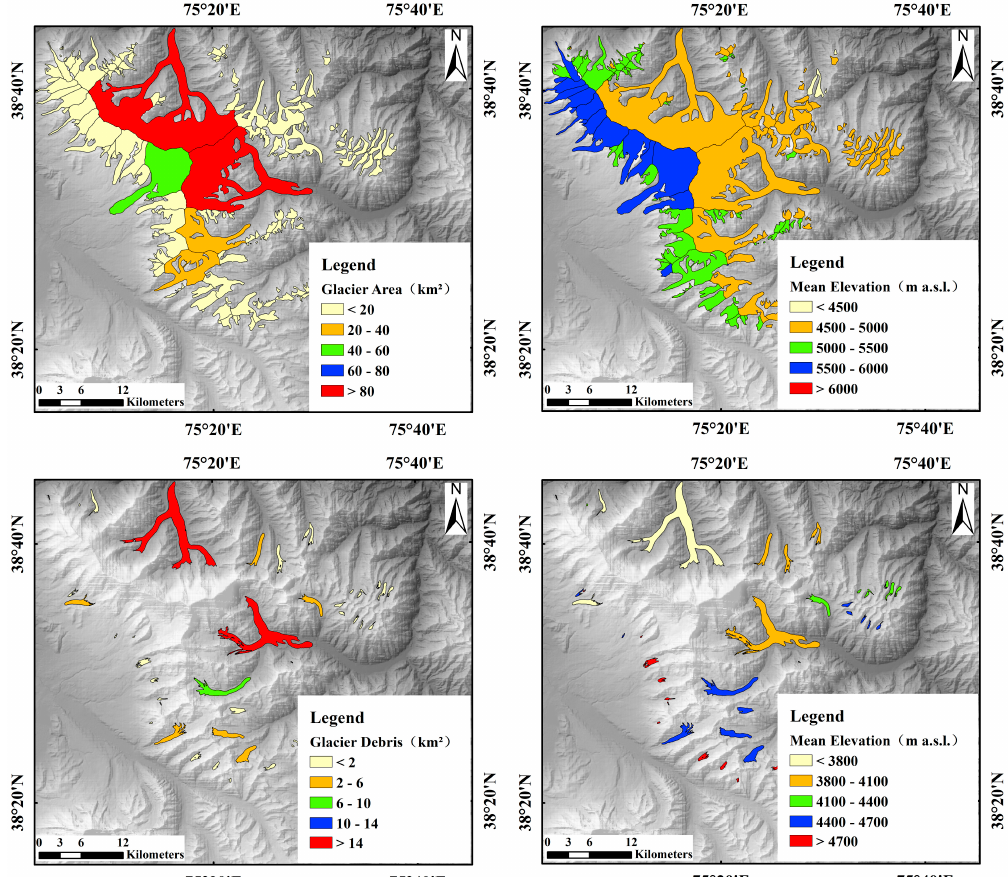
Figure 11. Glacial area and elevation with a hillshade view of ASTER GDEM V2 in the